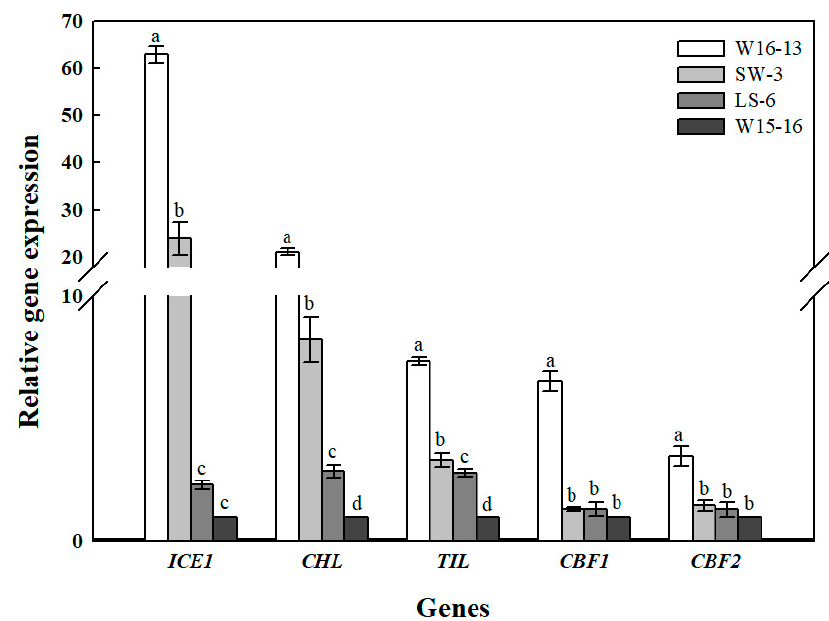
Figure 14. Gene expression analysis of cold stress wucai leaves in ET [8/2 °C (d/n)]. Values represent the mean ± SE ( n = 3). Values with the same letter are not significantly different at the p < 0.05.